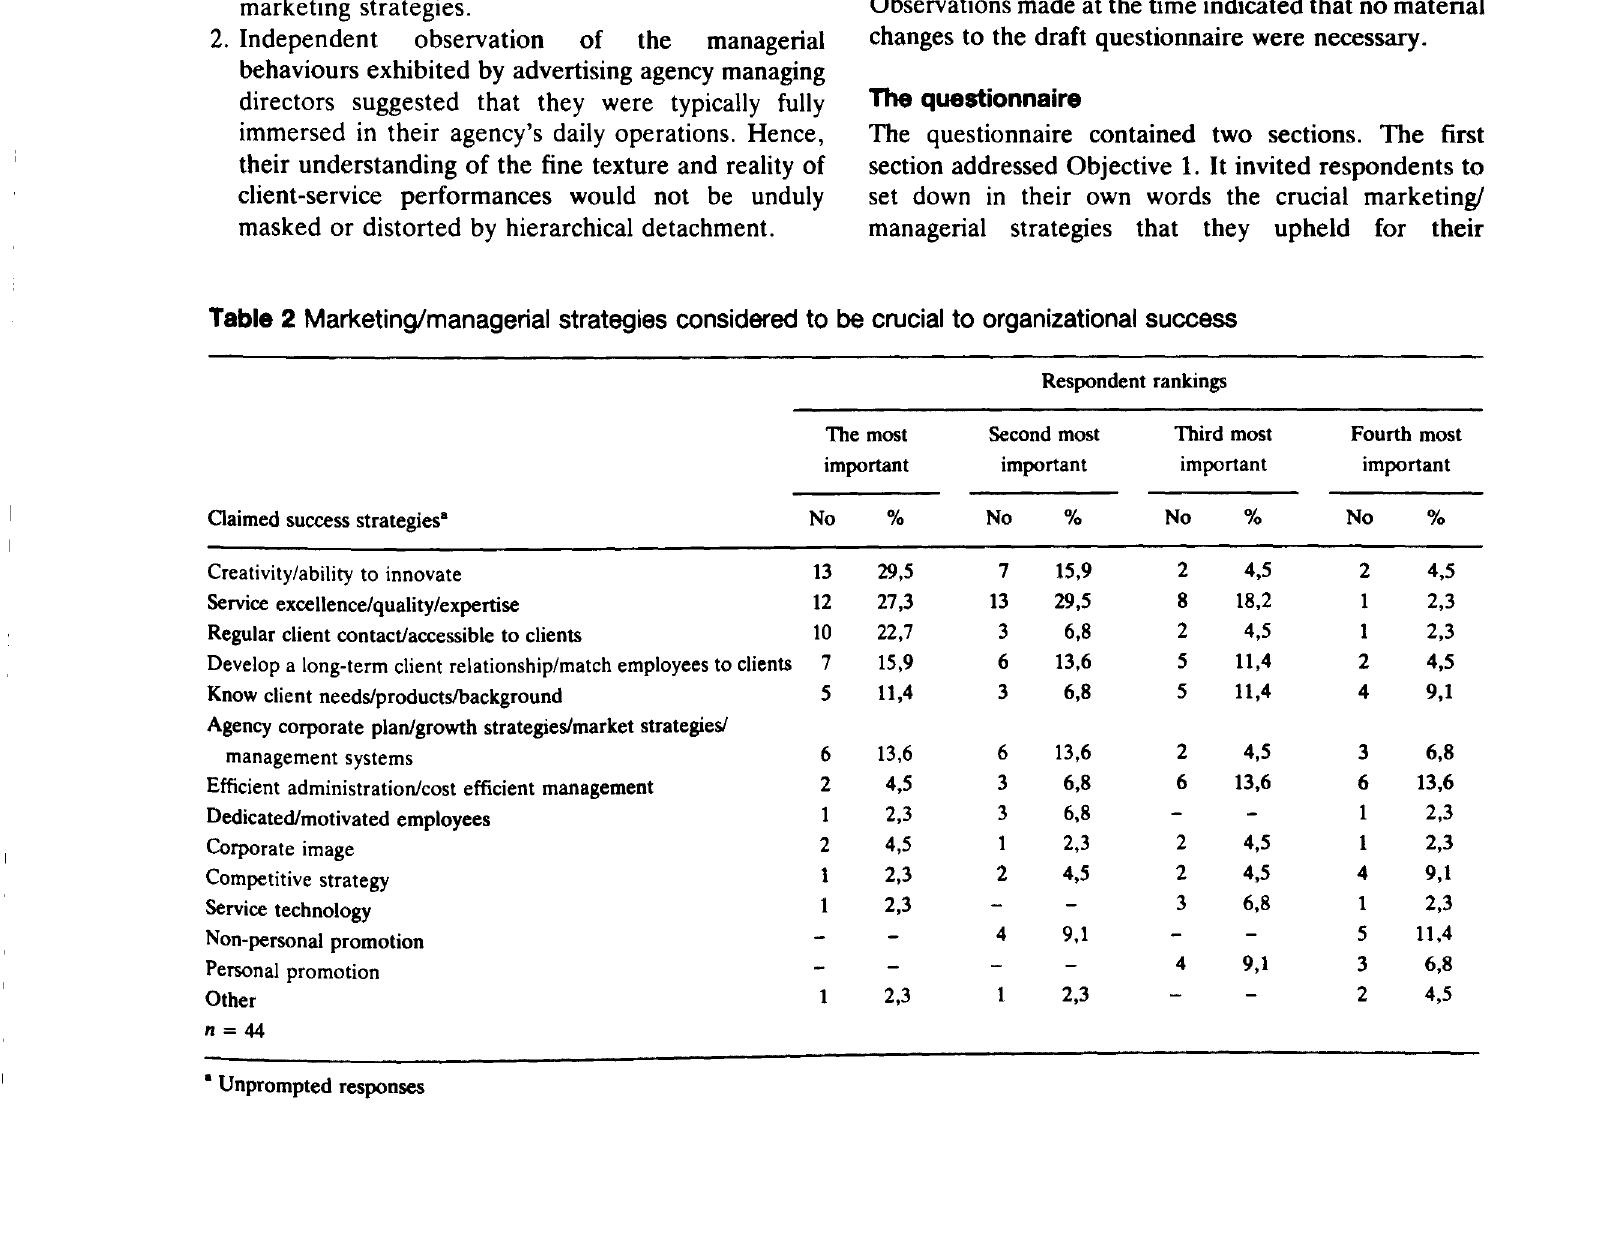
Table 2 Marketing/managerial strategies considered to be crucial to organizational